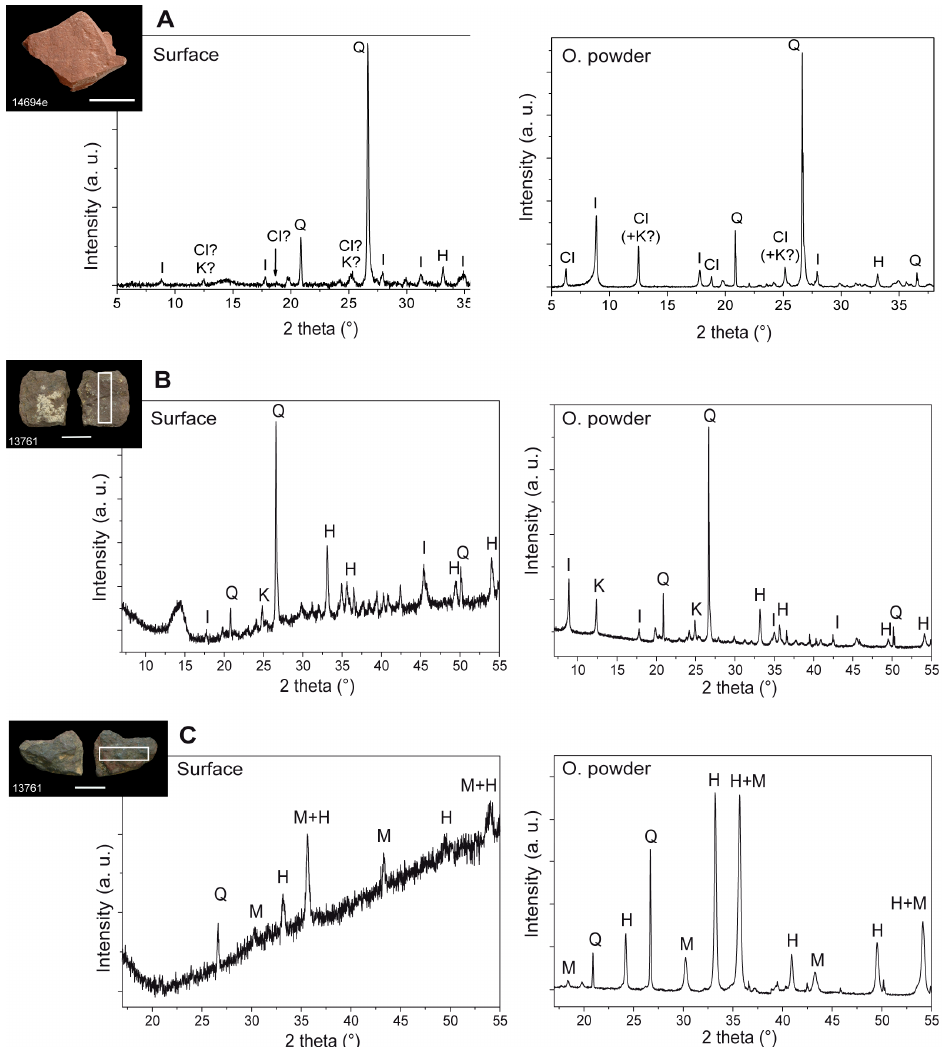
Figure 1. XRD patterns of a geological piece of shale ( A ), an archeological piece of shale ( B ), and an archeological piece of ferricrete ( C ): comparison between the surface oriented powder samples (O. powder). Legend—Cl: chlorite; H: hematite; I: illite/mica; K: kaolinite; M: maghemite; Q: quartz; a.u.: arbitrary